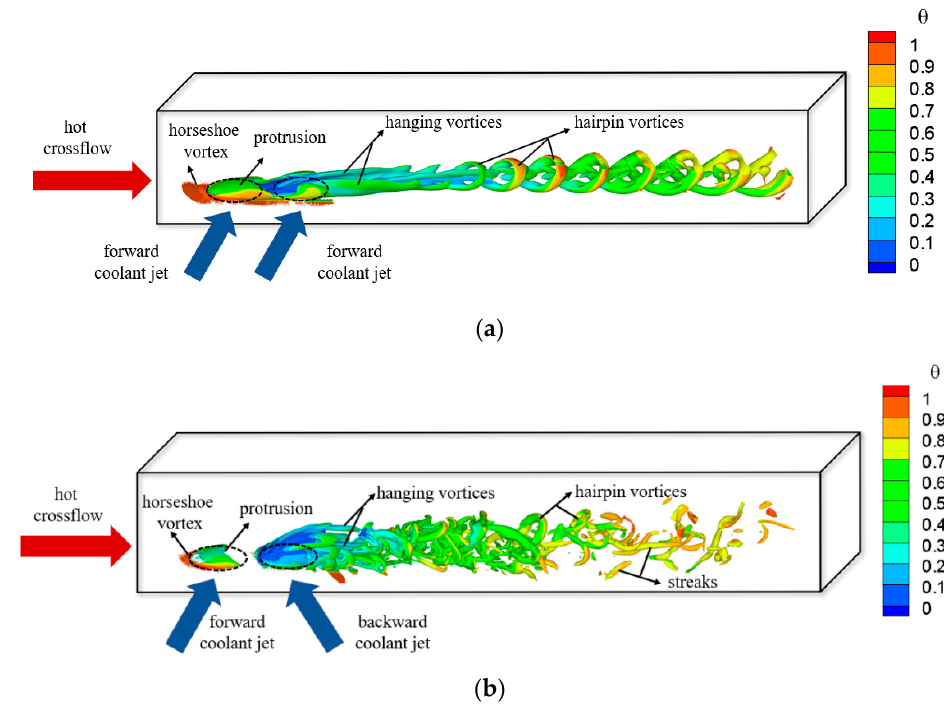
Figure 7. Instantaneous coherent structures of ( a ) Case 1 and ( b ) Case 2.